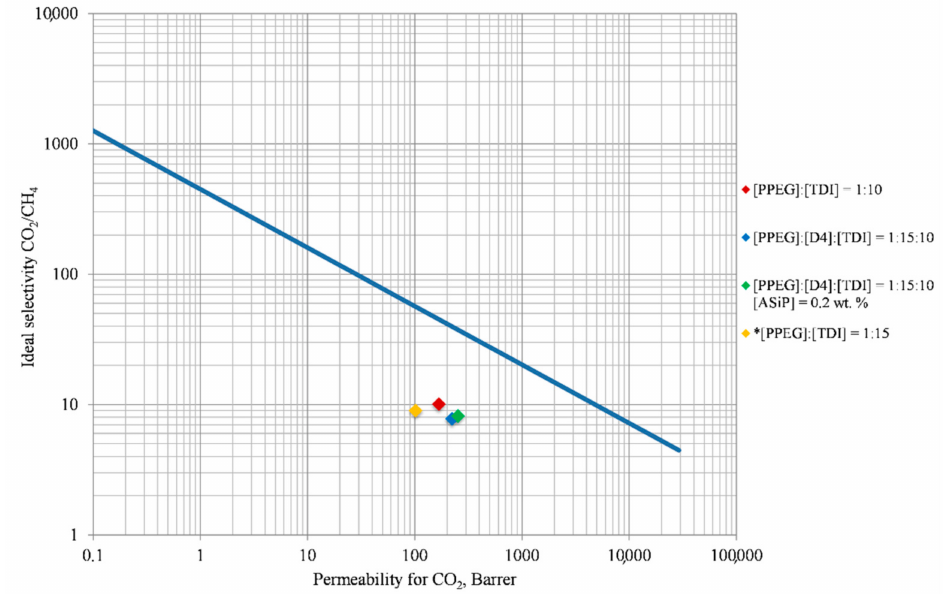
Figure 17. Upper bound correlation for CO 2 /CH 4